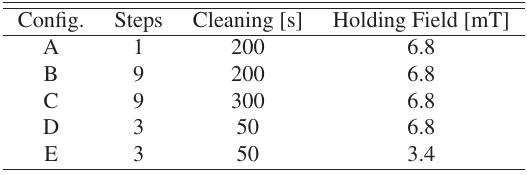
Table 1. Running configurations for 2017 data set. The number of steps refers to the number of counting positions the dagger detector was lowered to when unloading the trap. The cleaning time is the duration after the trap is closed that the cleaners are lowered into the trap. Holding Field gives the strength of the applied magnetic